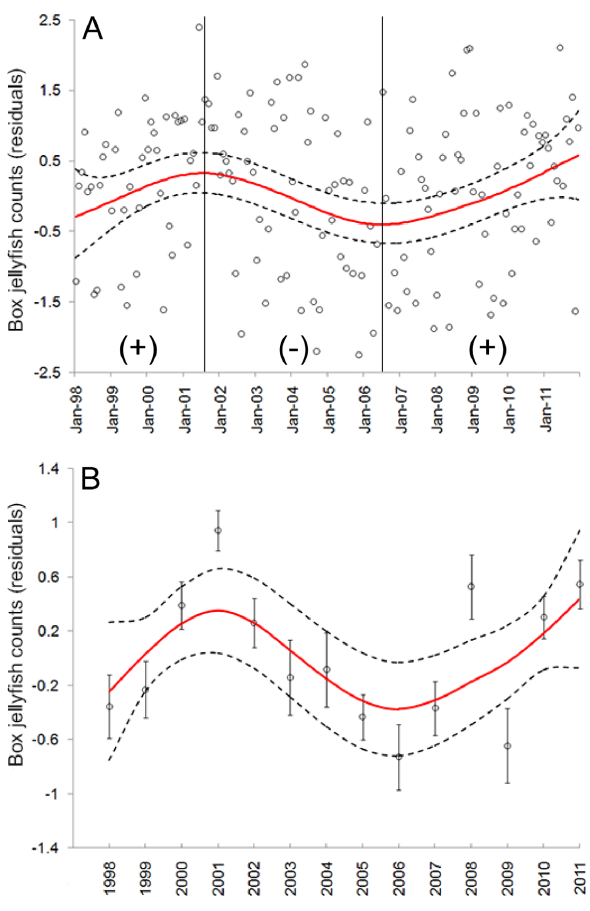
Figure 2. Long-term changes in abundance of box jellyfish at Waikiki Beach. Trends of box jellyfish abundance (solid line) over time was determined by the Generalized Additive Model ( GAM ) using (A) monthly and (B) annual mean counts. Data were log-transformed and detrended before analysis. Dashed lines indicate 95% confidence limits. Vertical solid lines indicate periods of significant ( Linear regression , p , 0.05) increase ( + ) or decrease ( 2 ) in box jellyfish counts. Bars show standard